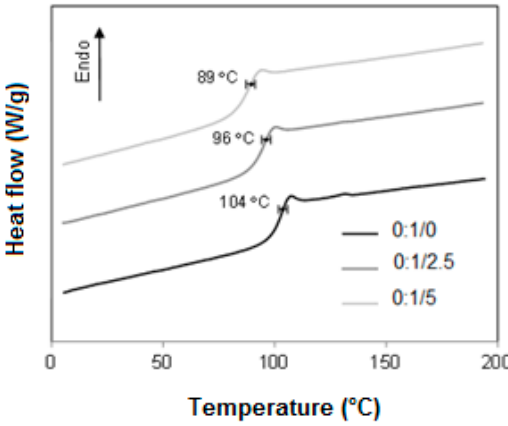
Figure 9. DSC thermograms for HIPS with 0, 2.5 and 5 phr of CNSL.